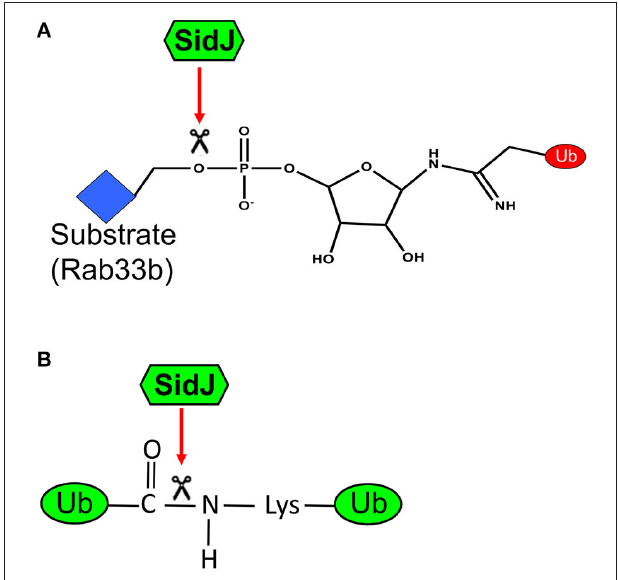
FIGURE 3 | A diagram of the dual biochemical activities of SidJ. (A) Cleavage of phosphodiester bond by SidJ. SidJ specifically recognizes the phophosdiester bond that links phosphoribosylated ubiquitin to serine residue on the substrate. This activity allows the substrate to return to its unmodified form; it also produces phosphoribosylated ubiquitin, which may be further hydrolyzed by enzymes from either the host or the bacterium or both. (B) Cleavage of isopeptide bond by SidJ. SidJ recognizes and cleaves the isopeptide bond that links ubiquitin to lysine residue of the substrate or another ubiquitin moiety. This activity produces free ubiquitin. Since mutants that retain only one of these two activities have not been isolated, the importance of the classical DUB activity of SidJ is not